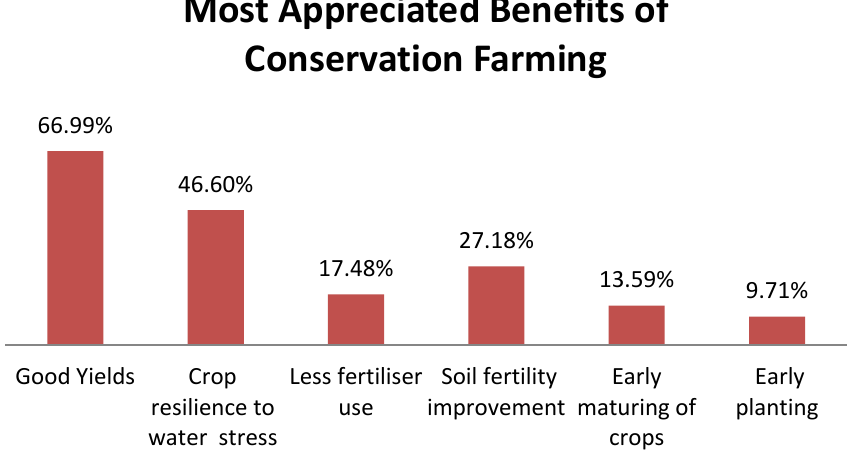
Figure 5. Most Appreciated Benefits of Conservation Farming by COMACO farmers.